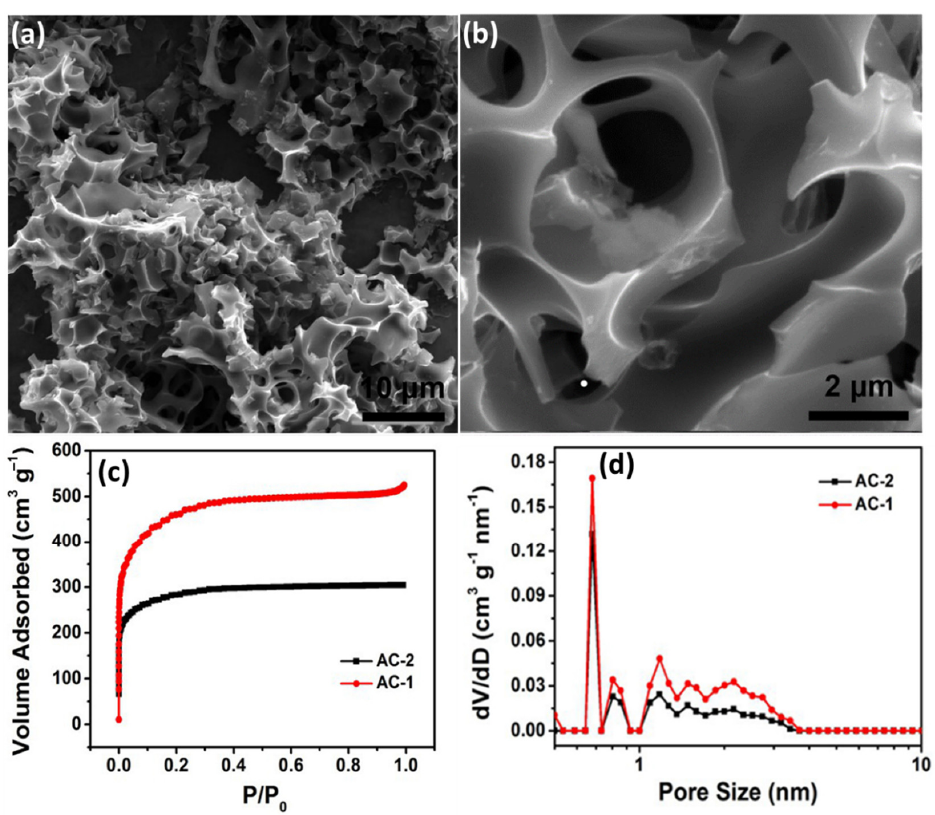
Figure 9. ( a ) The SEM micrograph at low resolution and ( b ) high resolution. ( c ) The nitrogen adsorption-desorption isotherms of AC-1 (chemically activated) and AC-2 (physically activated) and ( d ) the pore size distribution of AC-1 and AC-2. Reproduced with permission from [64], Elsevier, 2018.